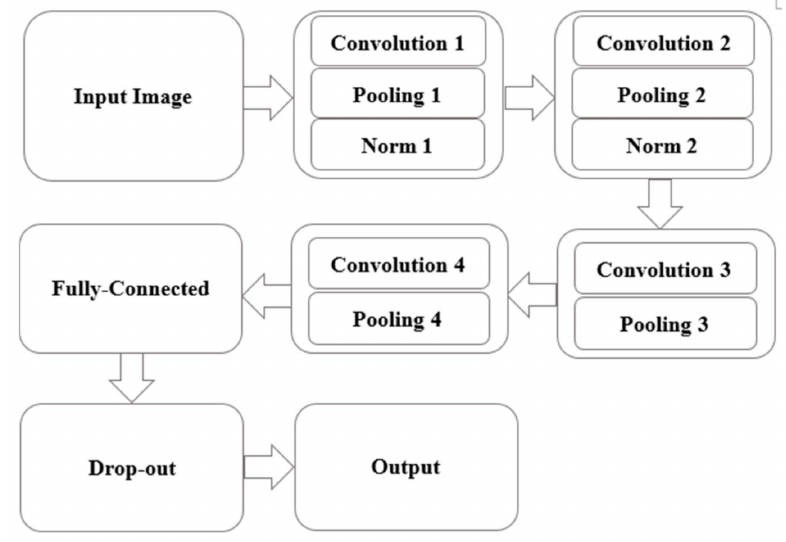
Figure 6. Convolutional neural network